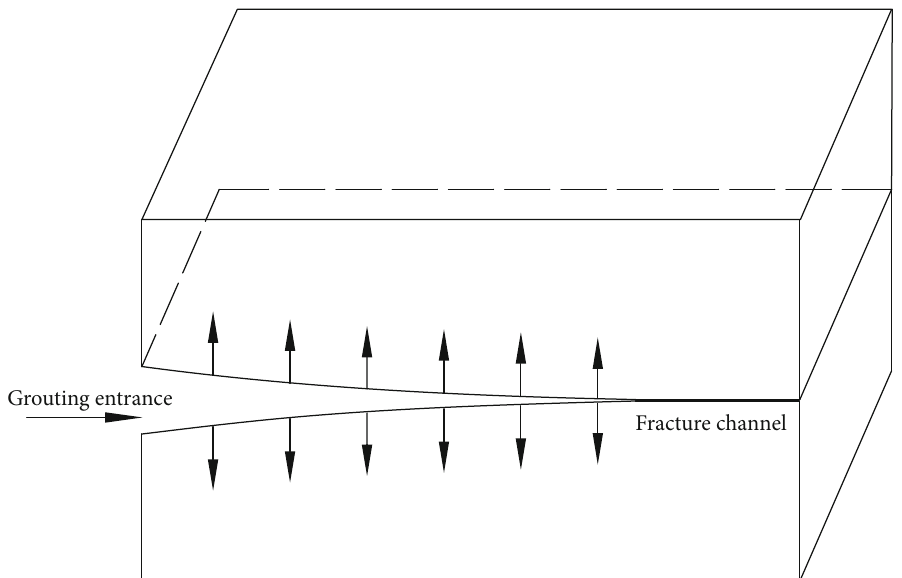
Figure 1: Schematic diagram of the slurry seepage process through a